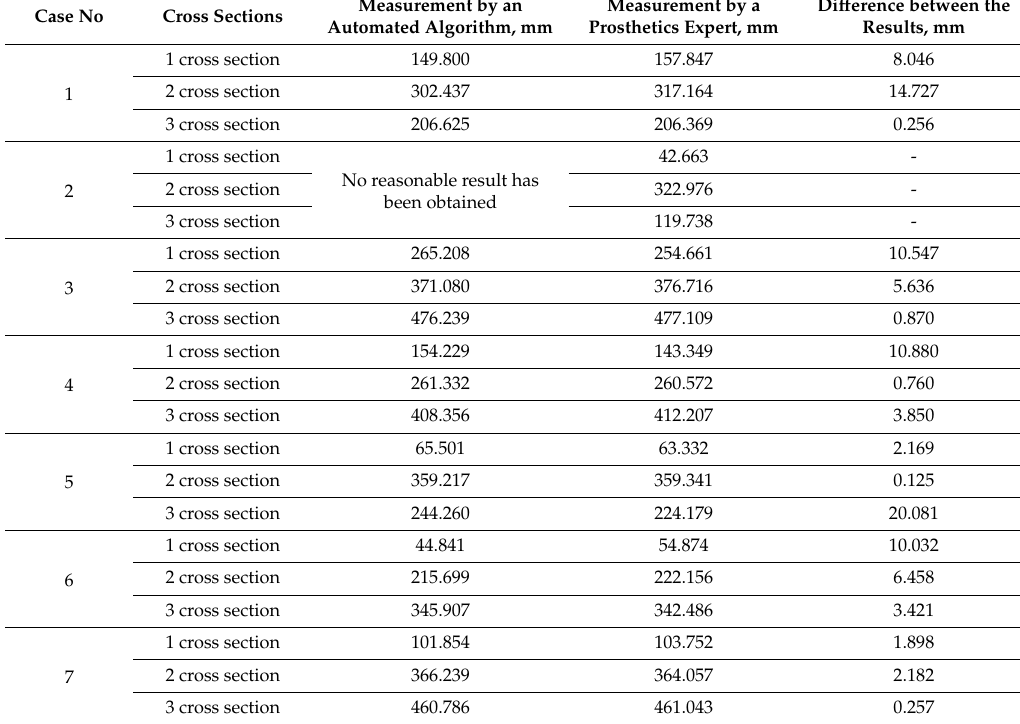
Table 1. Summary of validation results based on experimental measurements from seven di ff erent patients compared against prosthetics expert